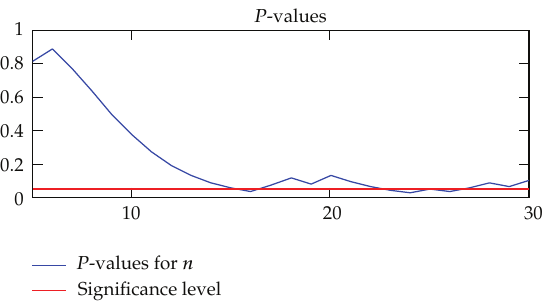
Figure 2: P values of 30 partial samples with π (cid:6) 0 . 50 and H 0 : π (cid:6) 0 . 50. The partial samples 1 to n are given on the abscissa, on the ordinate the corresponding P values. The red line indicates the significance level of